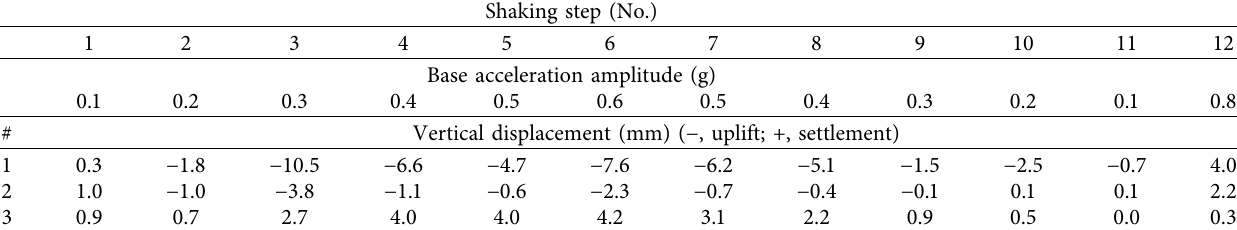
Table 4: Pipe vertical displacements summary (extracted from [34]). Shaking step